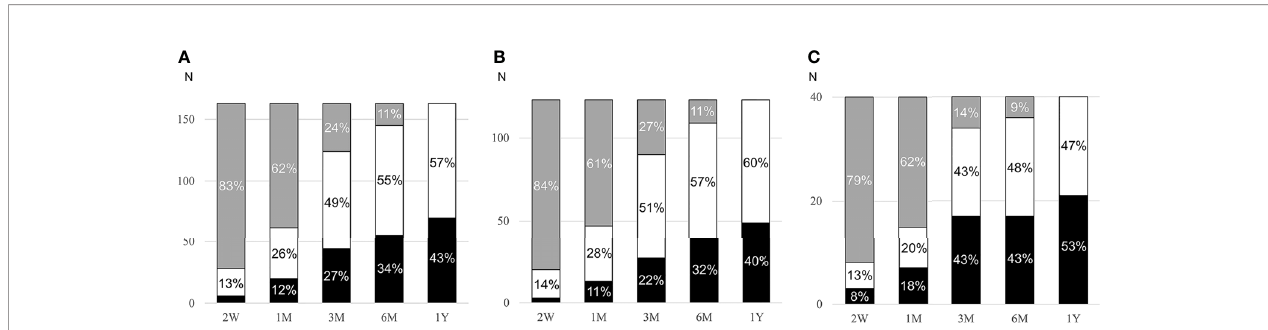
FIGURE 2 | Cumulative rates of target renin achievement during MRA therapy. MRA, mineralocorticoid receptor antagonist; PA, primary aldosteronism; LRH, low-renin essential hypertension; W, weeks; M, months; Y, year. Changes of target renin rates in all participants ( A , n=163), PA patients ( B , n=123), and LRH patients ( C , n=40) during follow-up after initiation of MRA. Patients who reached target renin are shown in black bars, those who continued to have suppressed renin in white bars, and those in whom renin was not assessed in grey